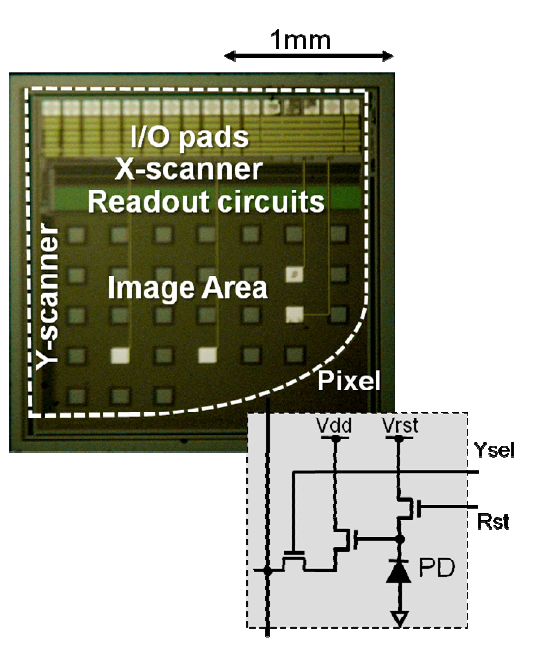
Figure 16. Photomicrograph of the chip. The inset shows the pixel circuit (adapted from